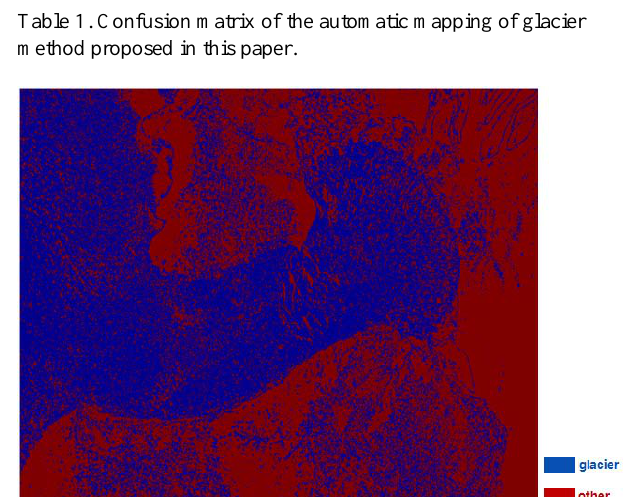
Table 1. Confusion matrix of the automatic mapping of glacier method proposed in this paper.